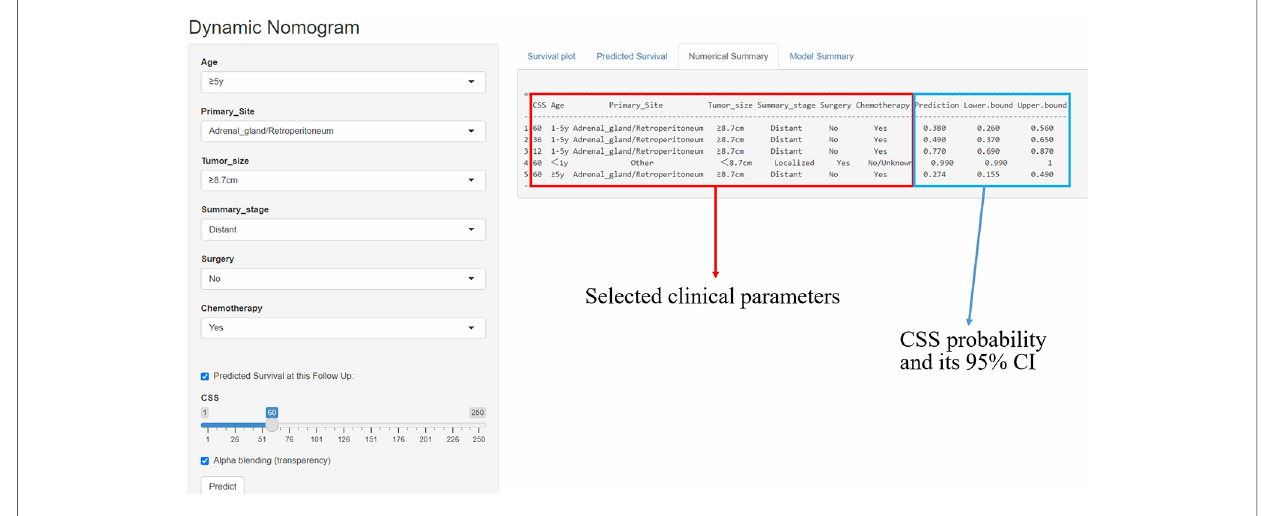
FIGURE 8 The interface of the web-based nomogram, and numerical summary of the CSS